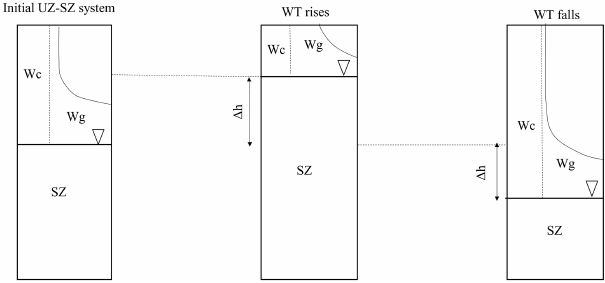
Figure 6. Conceptualisation of the interaction between UZ and SZ in MOBIDIC–MODFLOW in rising and falling water table condi-